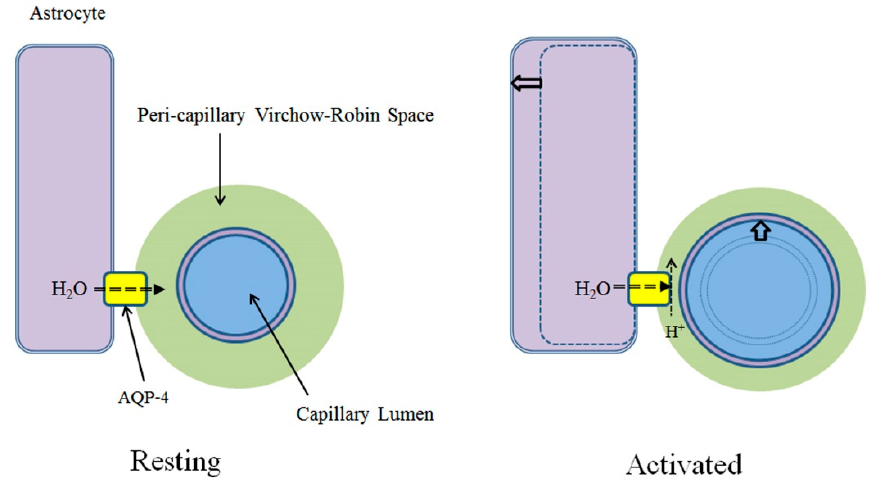
Figure 5. At the VRS, neural activation produces extracellular acidification accompanied by increase in rCBF and astrocyte swelling. Proton inhibition of AQP-4 results in a reduction of water flow from astrocytes into the peri-capillary Virchow-Robin space, reduction of peri-capillary fluid pressure, capillary lumen expansion, increase rCBF and astrocyte swelling. Modified from Reference [9].